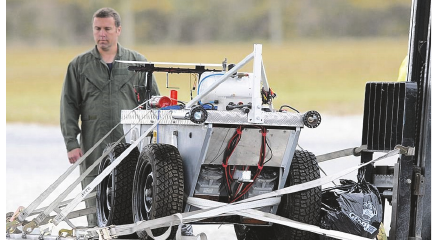
Figure 3: Robot of Western Australia Water